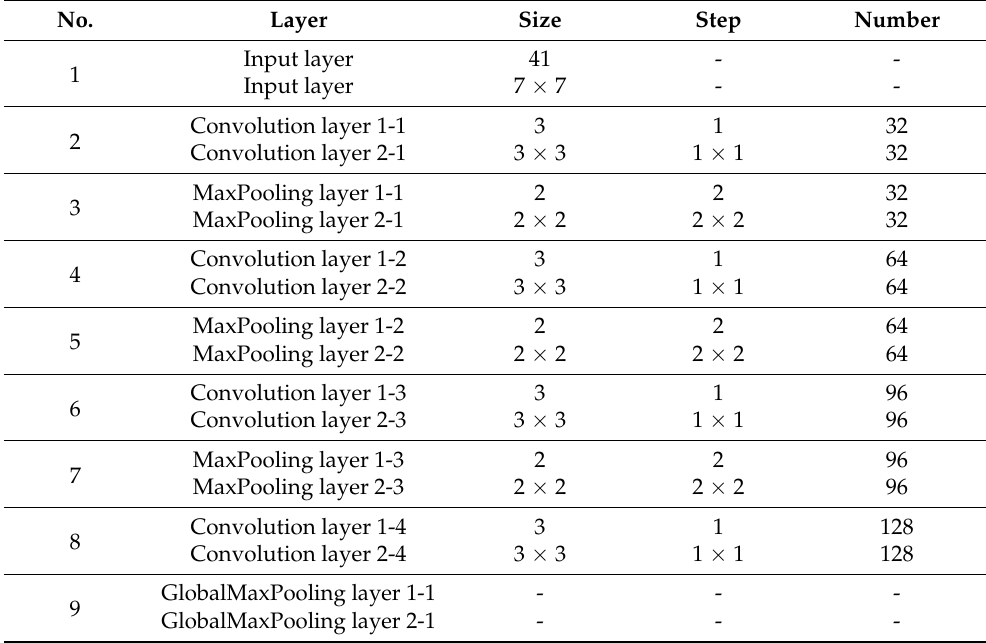
Table 1. The FCNN parameters.